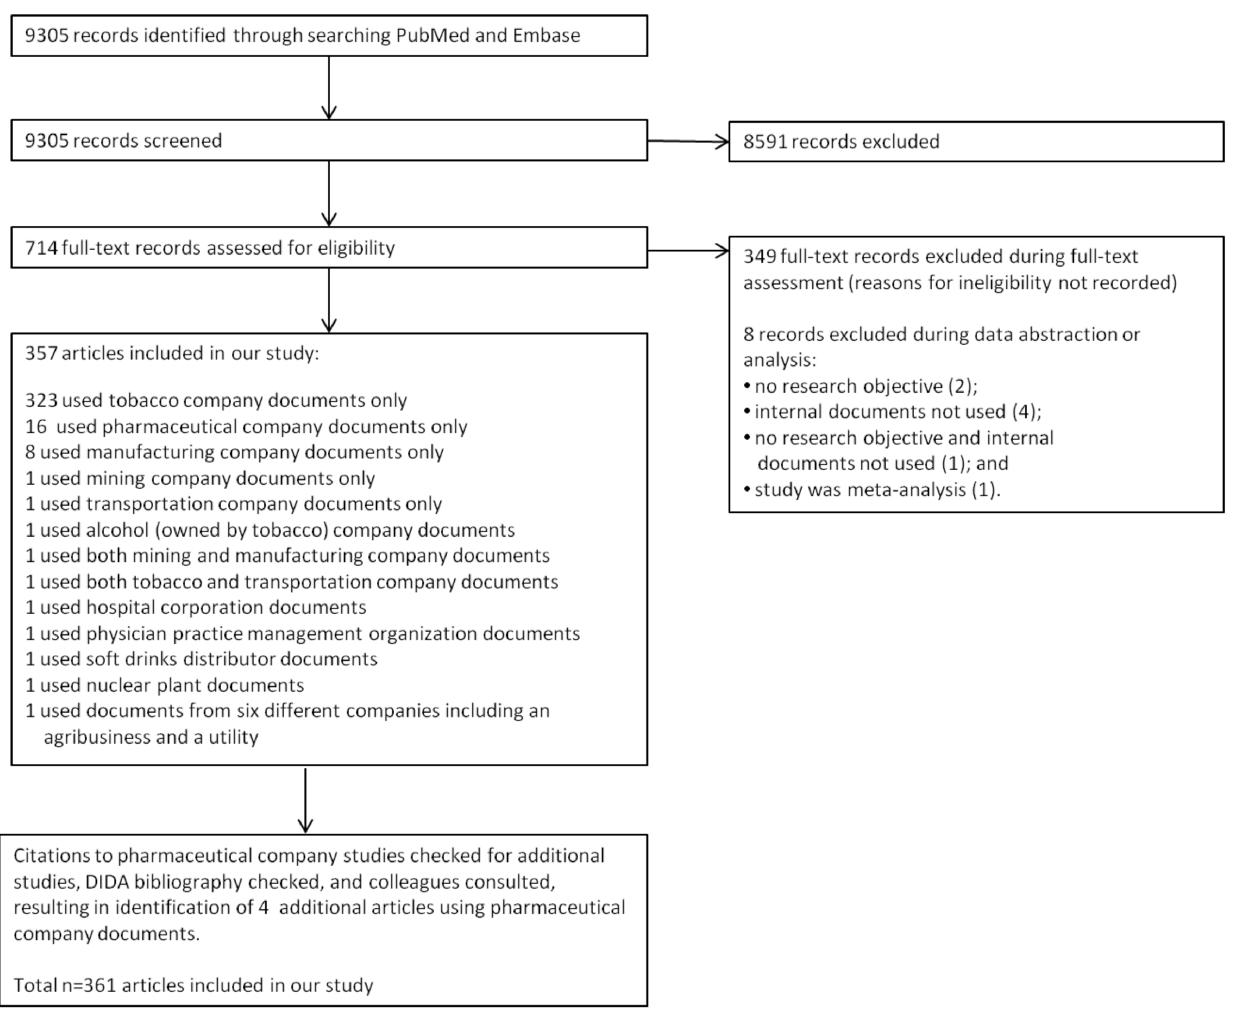
Figure 1. Flow chart of articles through the screening process.